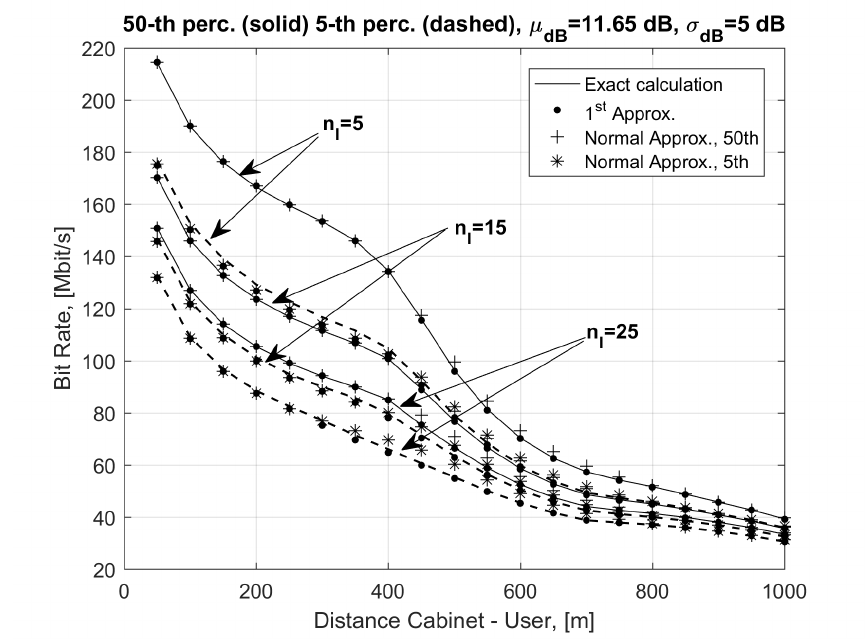
Figure 2. Bit rate vs cabinet-to-user distance for n I = 5, n I = 15 and n I = 25 (50th and 5th percentile).